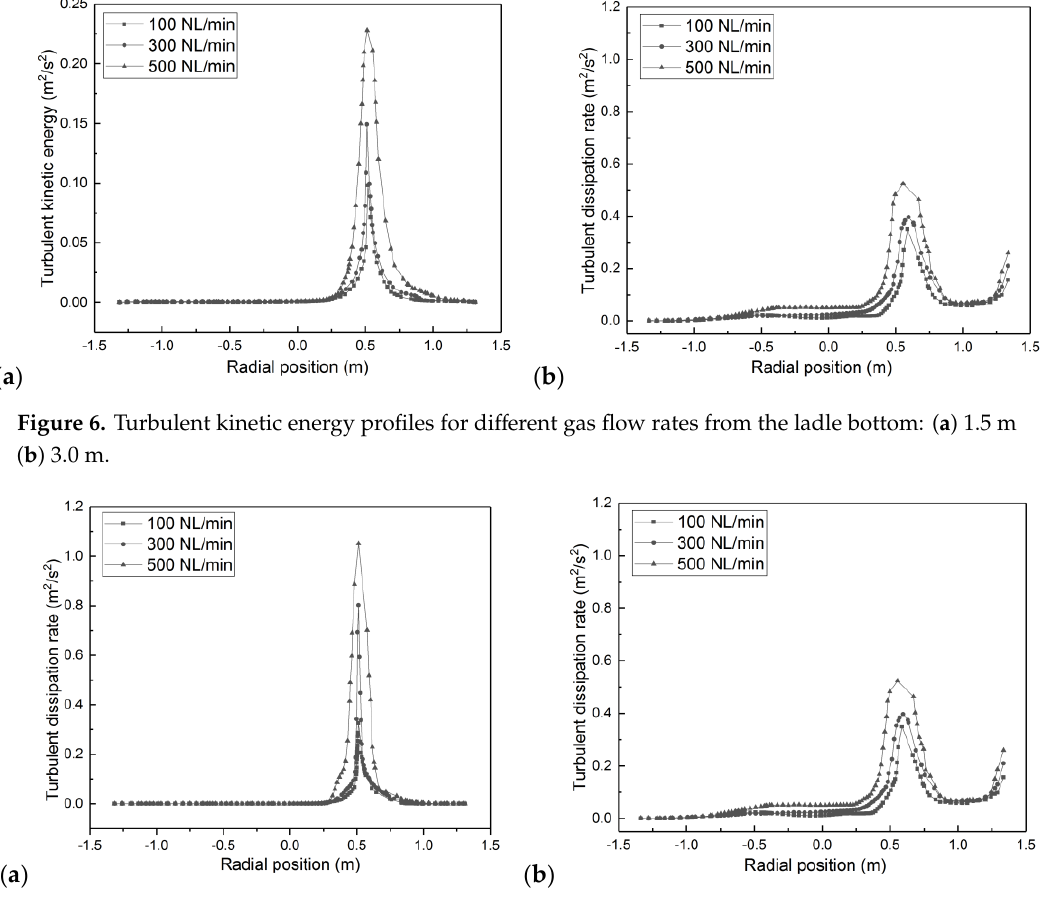
Figure 7. Turbulent dissipation rate profiles for different gas flow rates from the ladle bottom: ( a ) 1.5 m ( b ) 3.0 m.